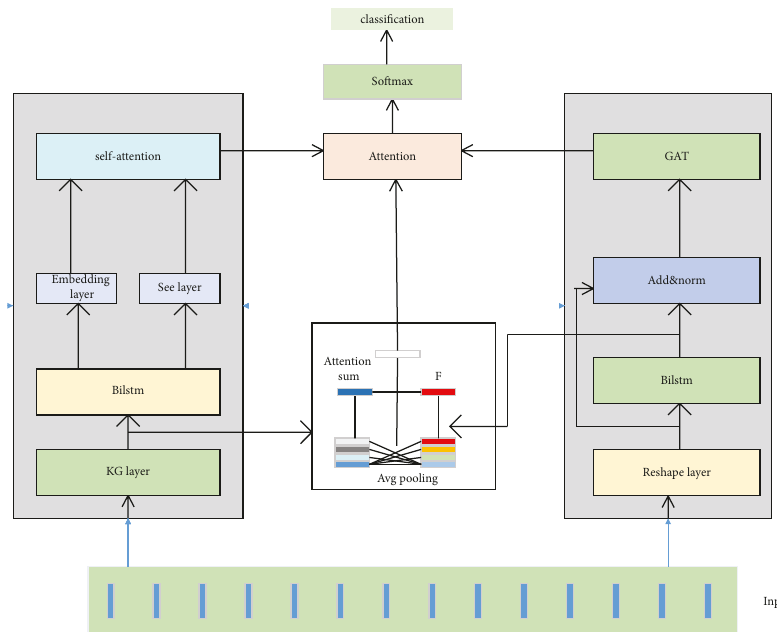
Figure 1: The overall framework of rumor detection based on knowledge enhancement and Graph Attention